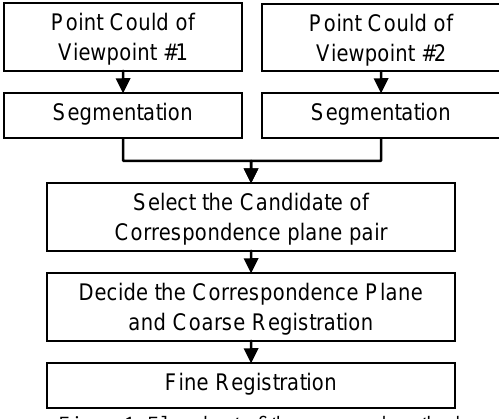
Figure 1. Flowchart of the proposed method.